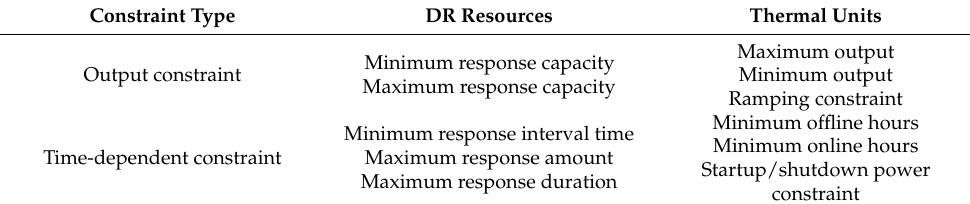
Table 2. Comparison of regulation constraints between thermal units and DR